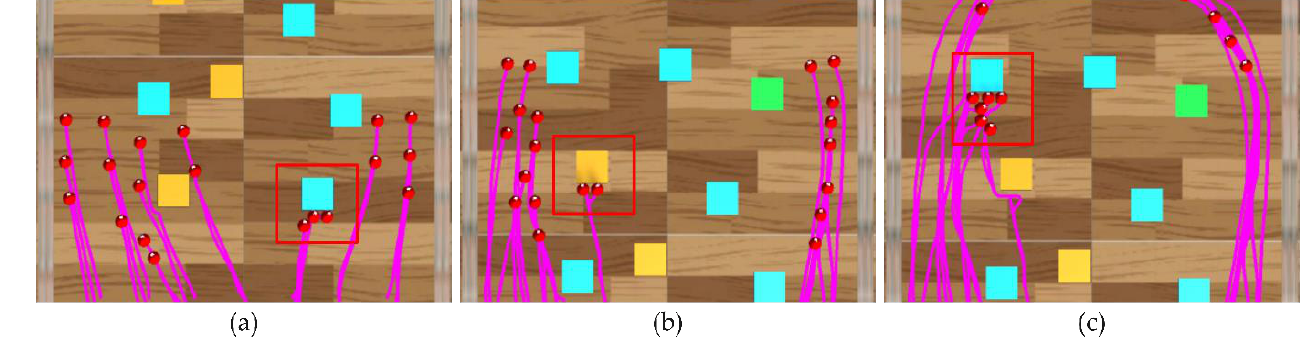
Figure 12. Collisions based on the method of [27]. ( a – c ) Collisions between the agents and